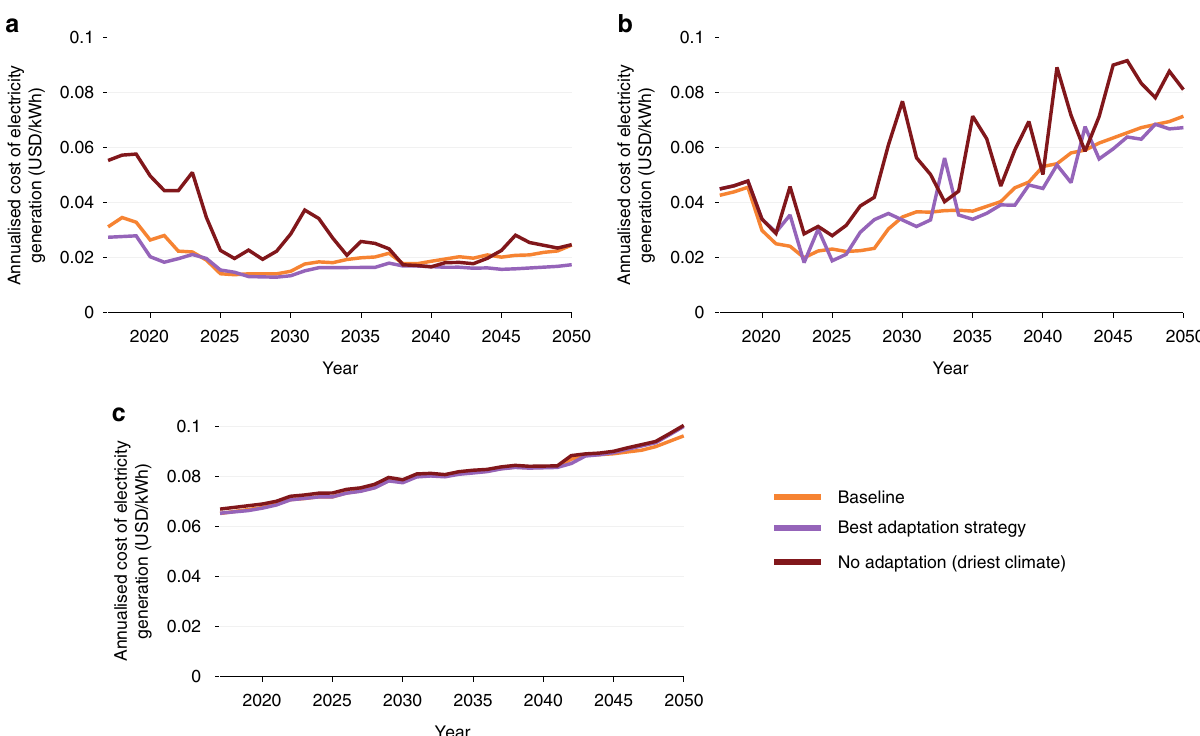
Fig. 3 Impact of climate on the cost of electricity generation. The fi gures illustrate the annualised cost of electricity generation (USD/kWh) for three scenarios: the baseline, a no-adaptation strategy for the driest climate and the most resilient adaptation strategy for three countries — a